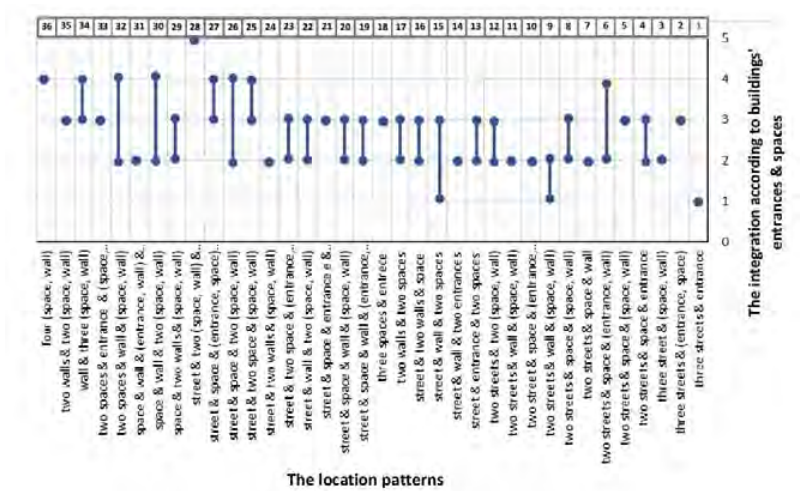
Figure 3. The relation between the space location patterns and the integration for space according to surrounding buildings’ entrances and spaces.